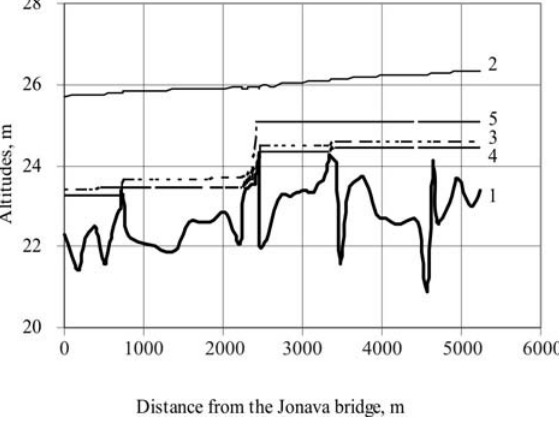
Fig. 3 . Longitudinal profiles of water levels: 1 – river bed bottom in deepest cross-section in waterway; 2 – when flood discharge is 70 m 3 /s; 3 – when Q = 3 m 3 /s and no dam; 4 – when environmental discharge is Q = 0.6m 3 /s and no dam; 5 – when Q = 0.6 m 3 /s and dam in place